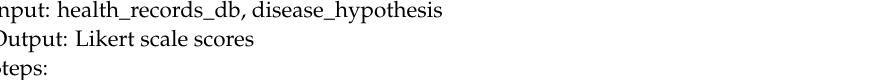
Listing 3. Pseudo-code of Likert-sale-score assignment algorithm for direct